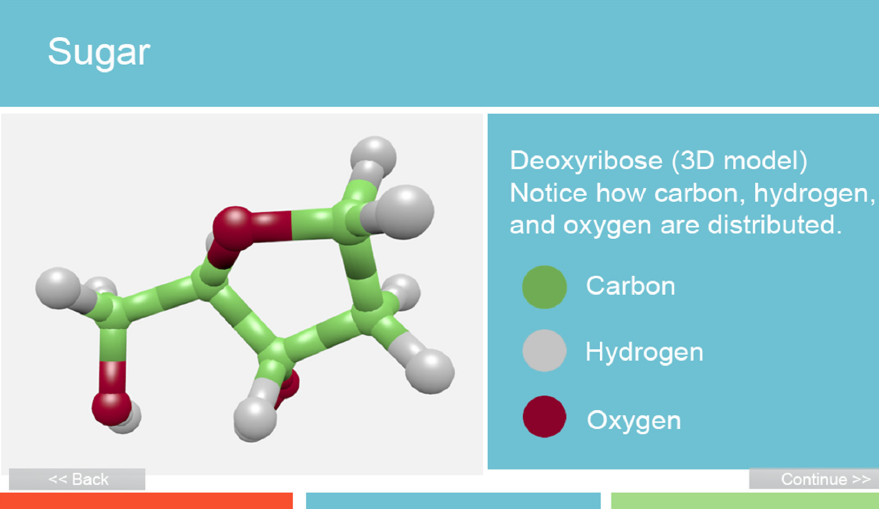
Figure 1. Examples of content for desktop screening: 3D representation of thymine.